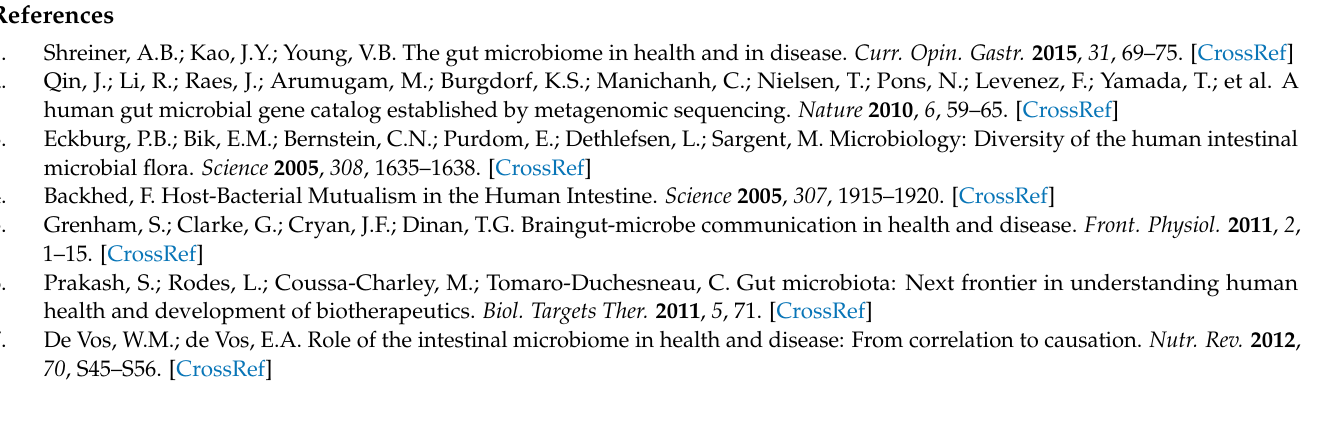
included in this review, using the Cochrane Risk of